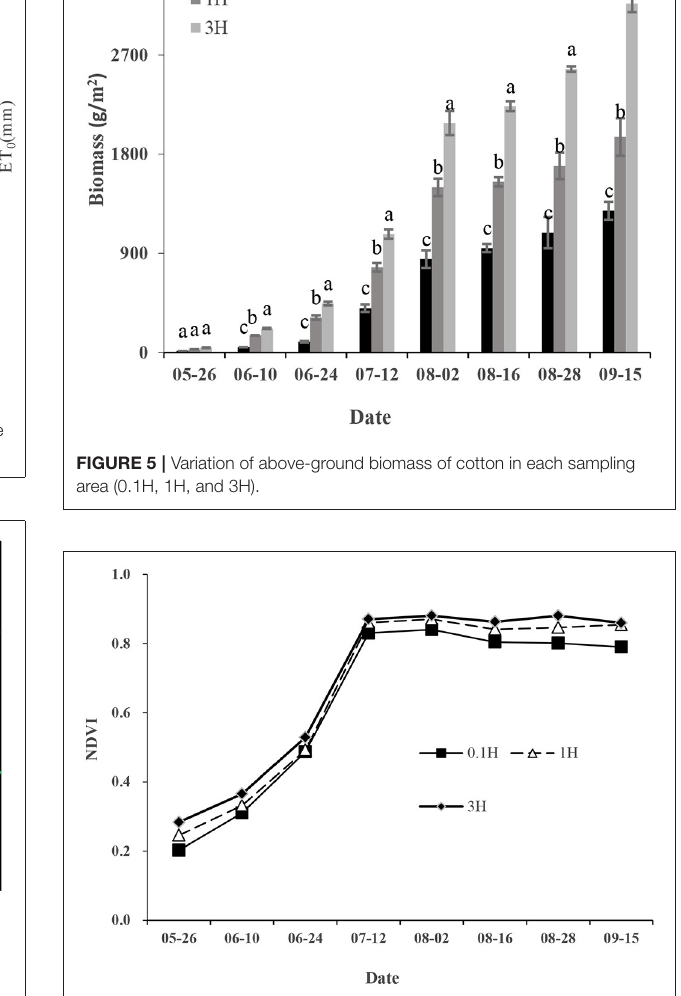
FIGURE 6 | Changes of cotton Normalized difference vegetation index (NDVI) at 0.1H, 1H, and 3H.